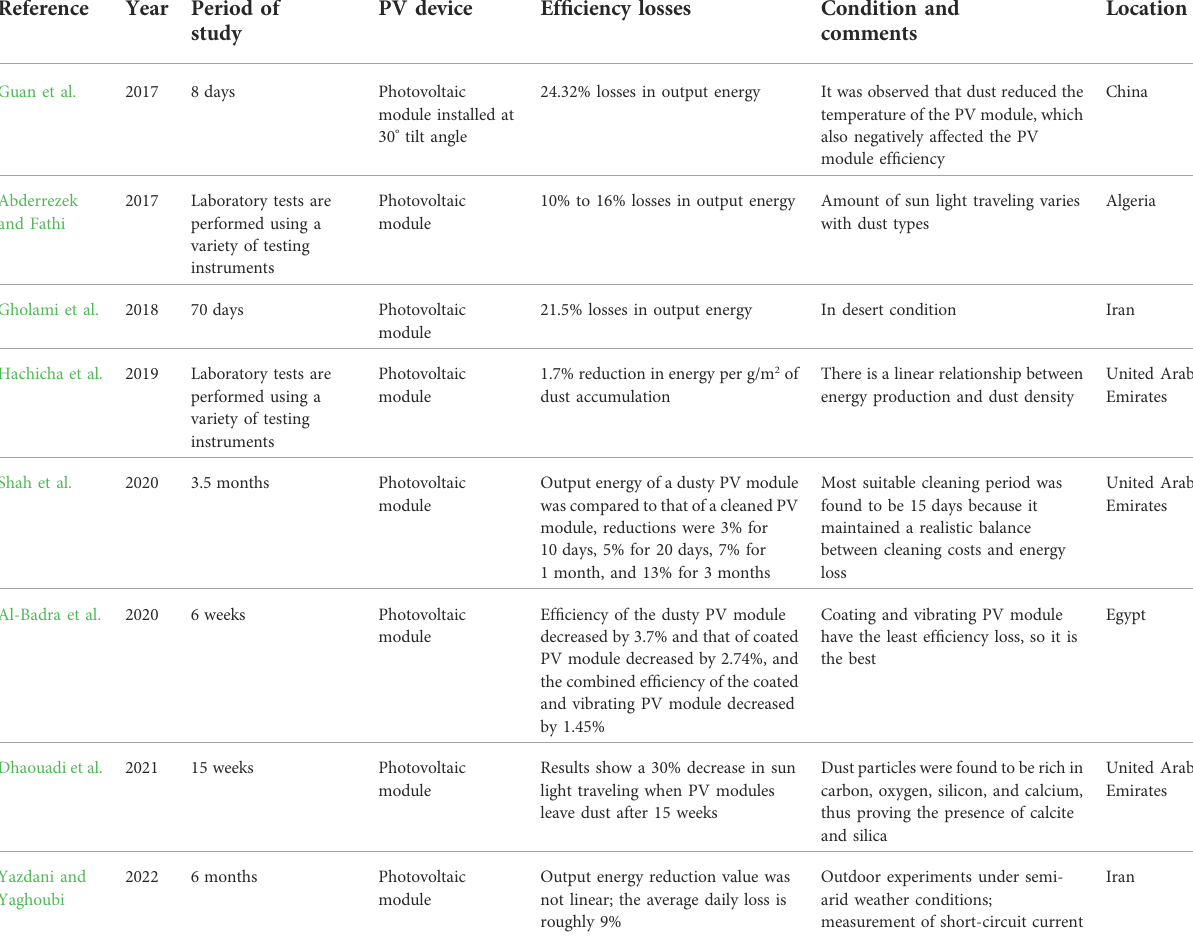
TABLE 1 Comparative analysis of the proposed research study and previous research studies on the effects of dust on photovoltaic